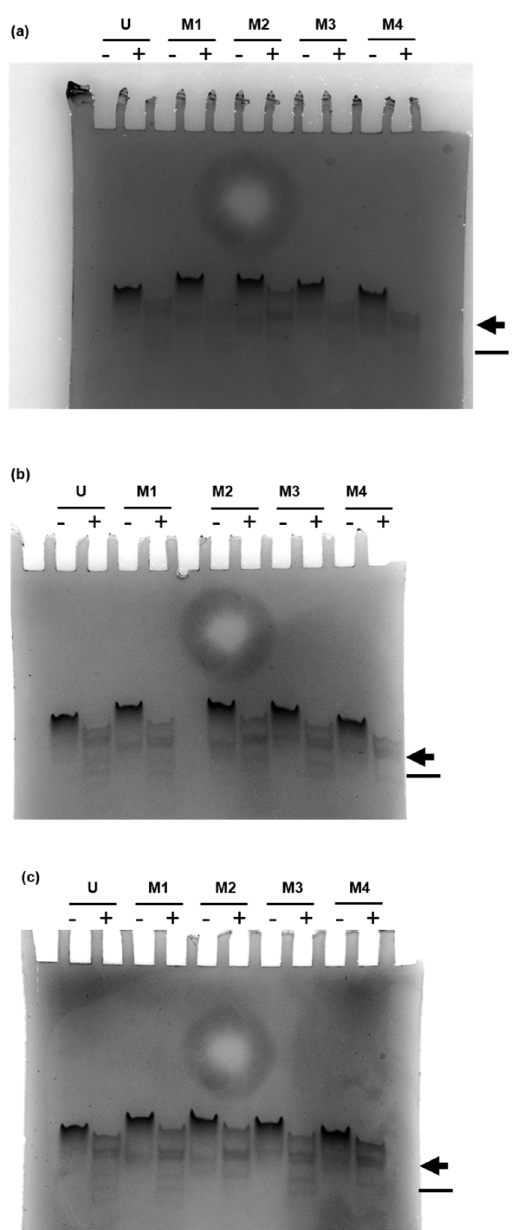
Figure A1. RNase T2 digestion patterns of RNA63 derivatives are influenced by the position of 2′-O-ribose methylation. ( a – c ) Unmethylated RNA63 (U) or methylated derivatives (M1, M2, M3, and M4) were treated with 0.005 units RNase T2/µg RNA (+) or mock-treated (−). RNA fragmentation was visualized in polyacrylamide gel electrophoresis. Position of RNA fragments of interest are indicated with an arrow ( ) and a line ( ). Three independent replicates of RNase T2 digestion are shown.